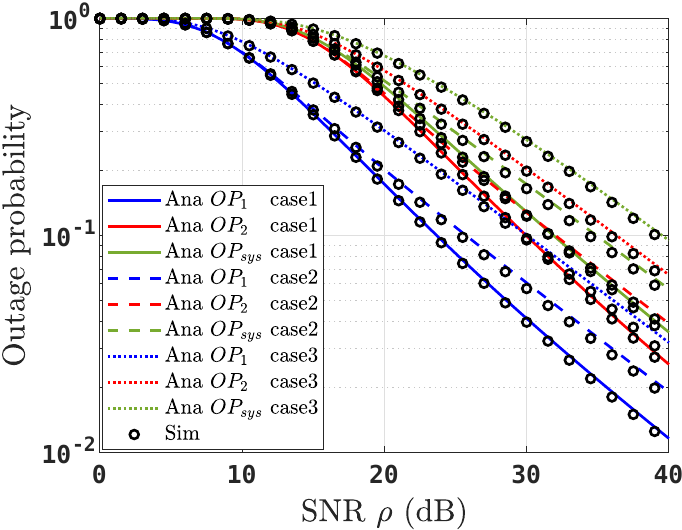
Figure 5. The effect of temperature gradient and air bubbles level on OPs